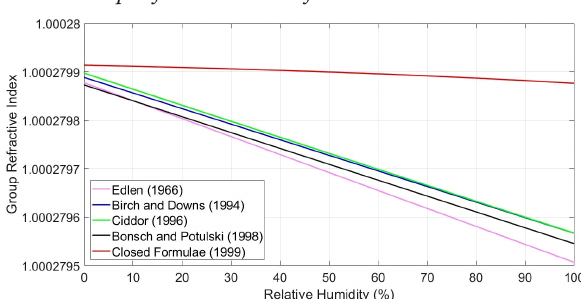
Figure 14. Effect of relative humidity on group refractive index of air calculated in EDM correction